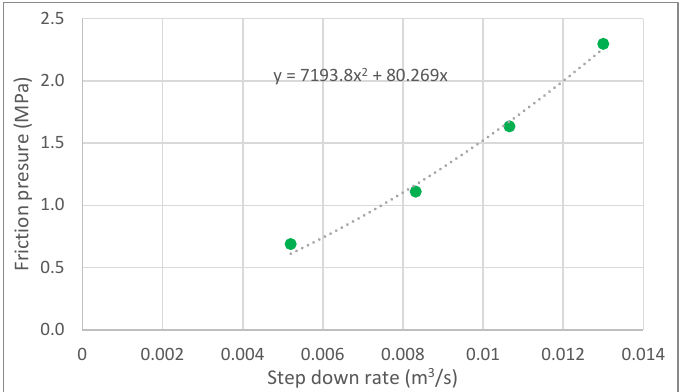
Figure 10. Friction pressure obtained from the step-down test performed in Zone 1 Cycle 7 during the 2019 injection. Annulus pressure is used, and hence, the friction pressure obtained here only reflects near-wellbore tortuosity in the openhole completion.